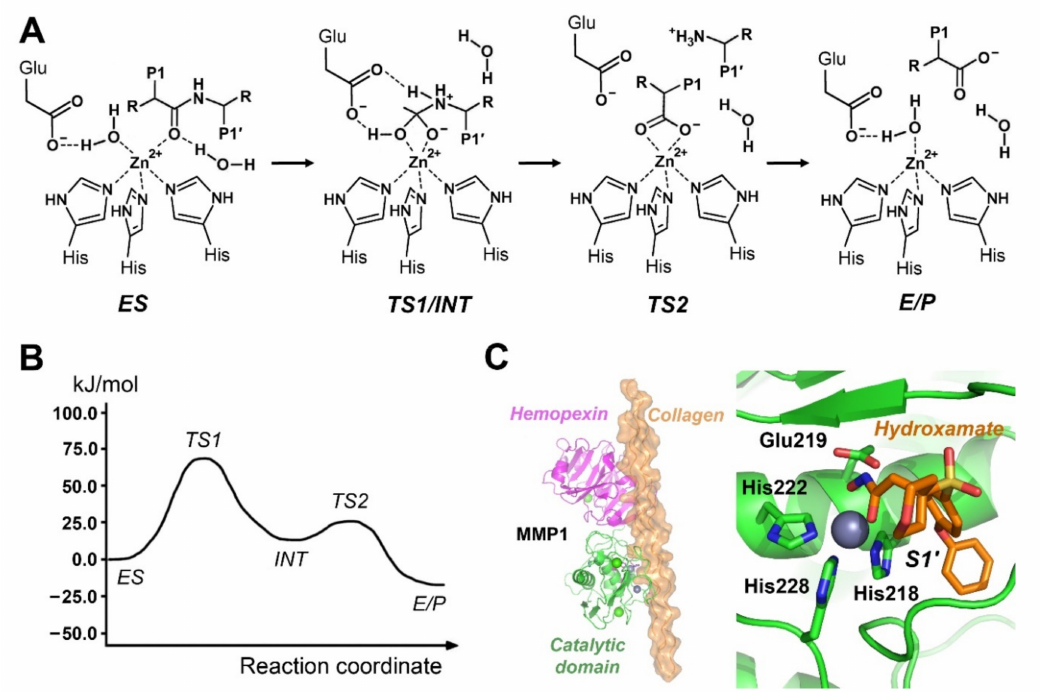
Figure 3. ( A ) Mechanism of metalloproteases. 1. Formation of a Michaelis complex (ES) and binding of the carbonyl O of the P1 residue to the catalytic Zn 2+ , which functions as oxyanion hole. 2. Nucleophilic attack by an activated water molecule, i.e., OH − (TS1), formation of a tetrahedral intermediate and transfer of an H + to the amide NH of the scissile bond (INT) 3. Cleavage of the scissile bond (TS2) and product release (E/P). Especially step 2 can be further subdivided into more steps. Structural examples with functional relevance are shown in Figure 3C. ( B ) The relatively simple free energy profile for MMP3 follows Pelmenshikov and Siegbahn (2002) [87]. ( C ) Left panel: MMP1 in complex with the natural substrate collagen (PDB 966C) corresponds to the ES complex. Right panel: MMP1 active site with a Zn 2+ bound hydroxamate inhibitor (PDB 4AUO), which partially resembles the intermediate